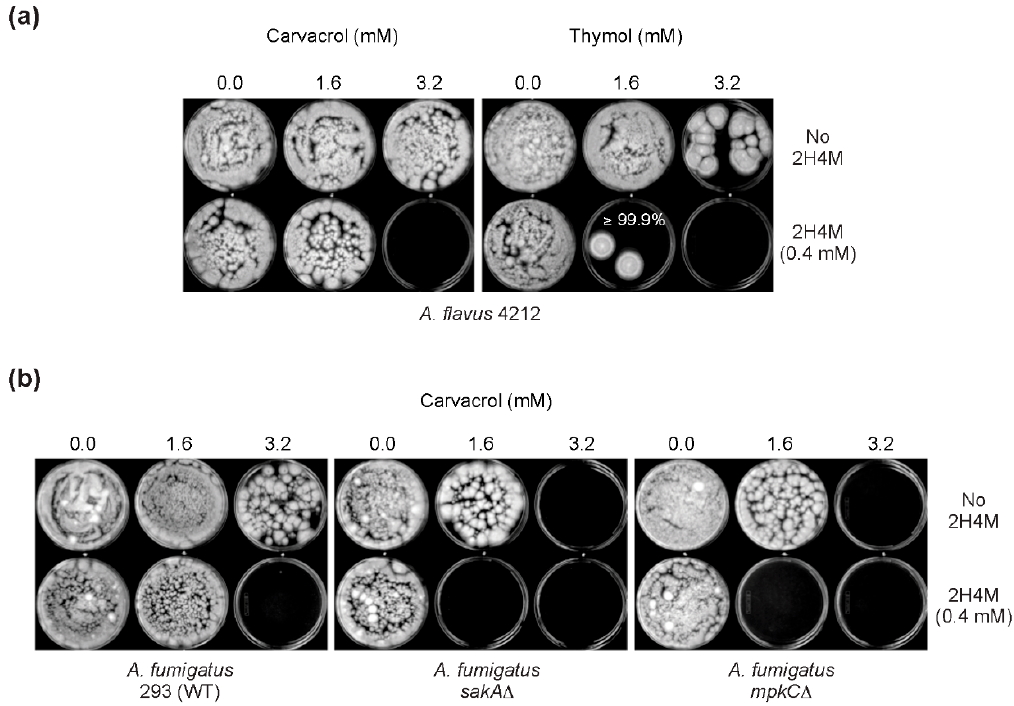
Figure 5. Chemosensitization test in aflatoxigenic Aspergillus or A. fumigatus (thymol or carvacrol + 2H4M). Exemplary bioassay showing co-application of thymol or carvacrol with 2H4M completely inhibited the growth of ( a ) aflatoxigenic A . flavus 4212 or ( b ) A. fumigatus . Results also showed that oxidative MAPK mutants ( sakA Δ , mpkC Δ ) were more sensitive to the chemosensitization compared to WT (Concentrations presented: 1.6 to 3.2 mM, carvacrol or thymol; 0.4 mM, 2H4M).